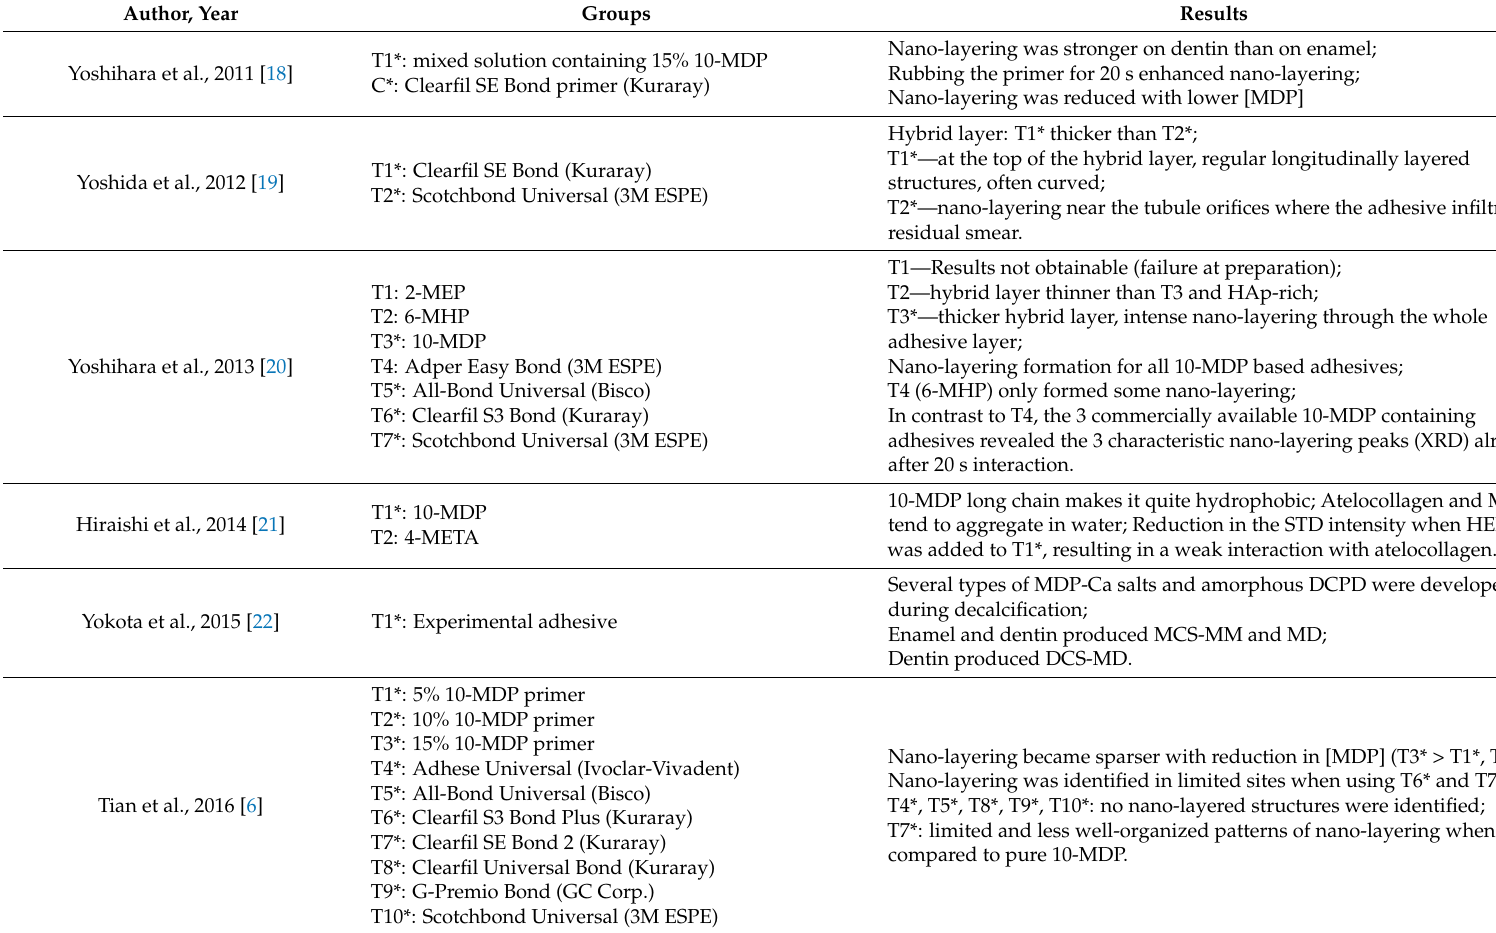
Table 4. Formation of nano-layered structures (MDP-Ca